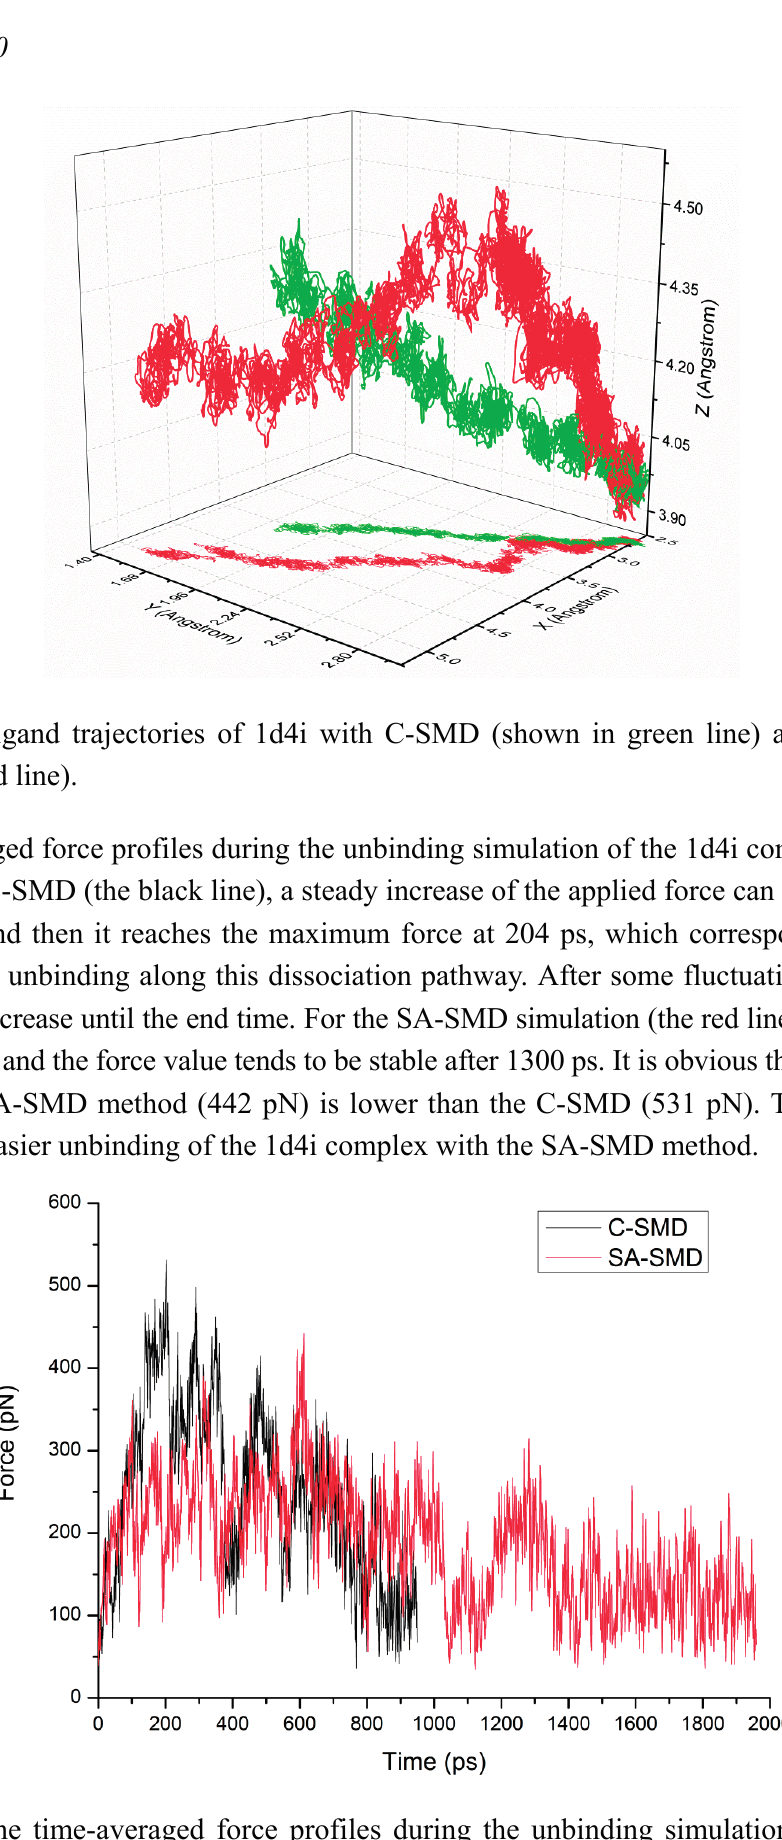
Figure 8. The time-averaged force profiles during the unbinding simulation of the 1d4i complex with C-SMD (shown in black line) and SA-SMD (shown in red